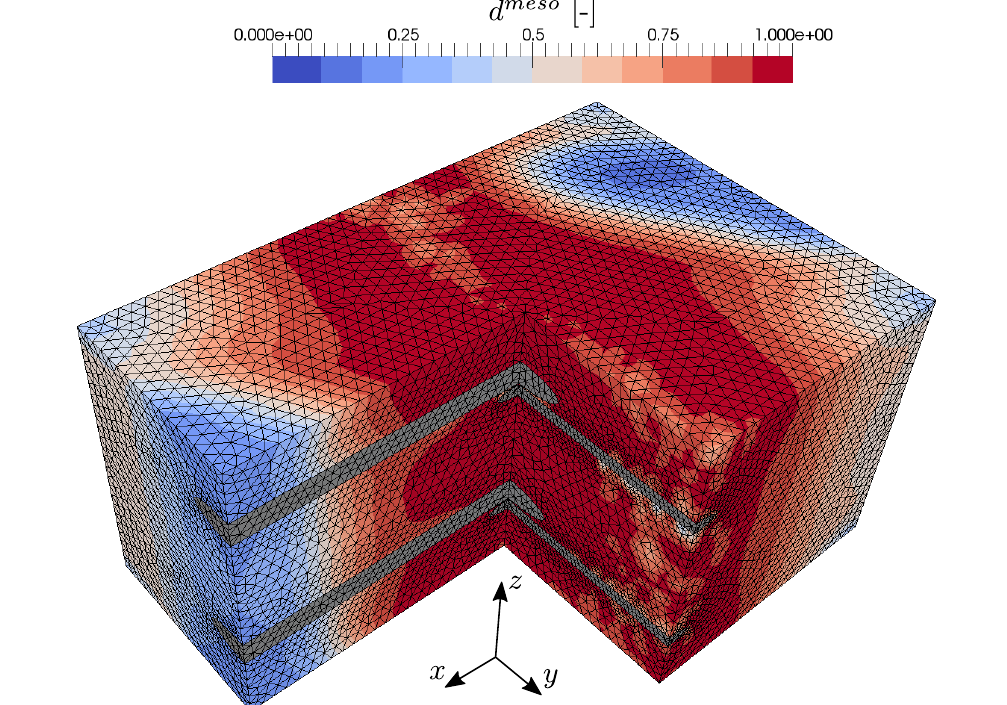
Figure 18. Evolved effective mesoscopic damage distribution due to in-plane shear loading with prescribed strain ¯ (cid:101) = [ ¯ (cid:101) xx = 0, ¯ (cid:101) yy = 0, ¯ γ xy ] .